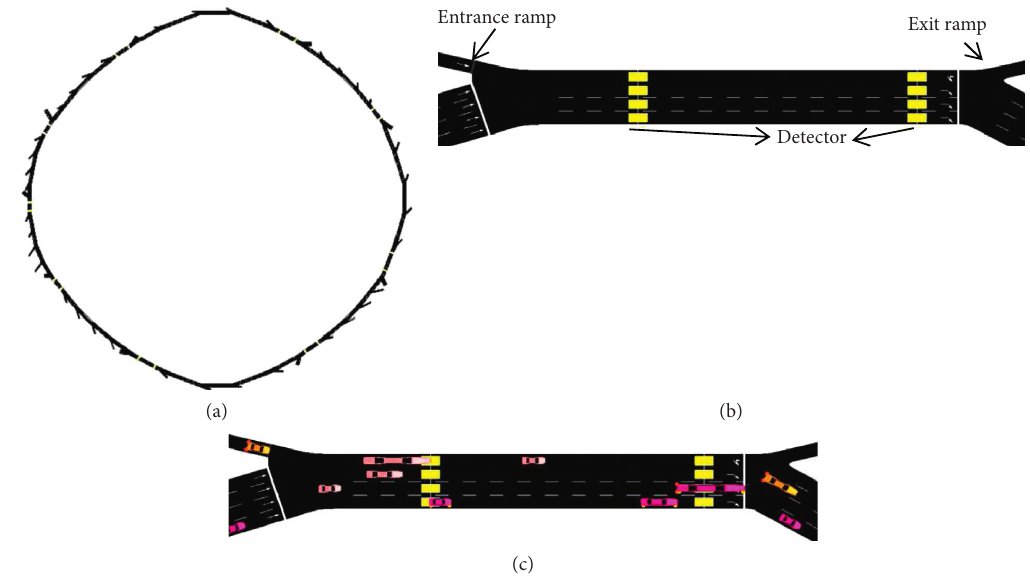
Figure 5: Schematic diagram of simulation modeling. (a) Road network model of 9 sections established by simulation. (b) Schematic diagram of the road section including the detector. (c) A road running diagram with one exit, one entrance, and two detectors.